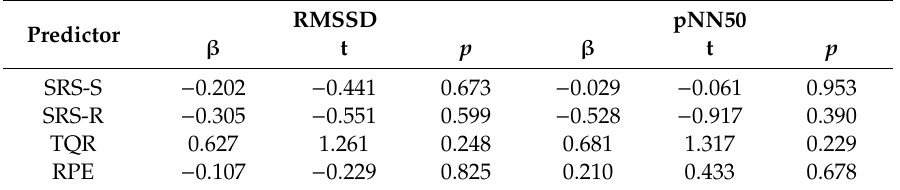
Table 4. Prediction analysis of subjective monitoring methods for RMSSD and pNN50 mean value over the course of competition. Predictor